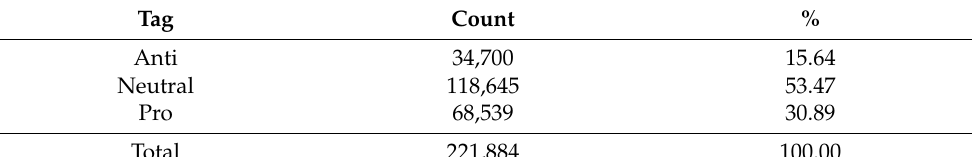
Table 4. Amounts and percentages of tweets classified according to the tags.